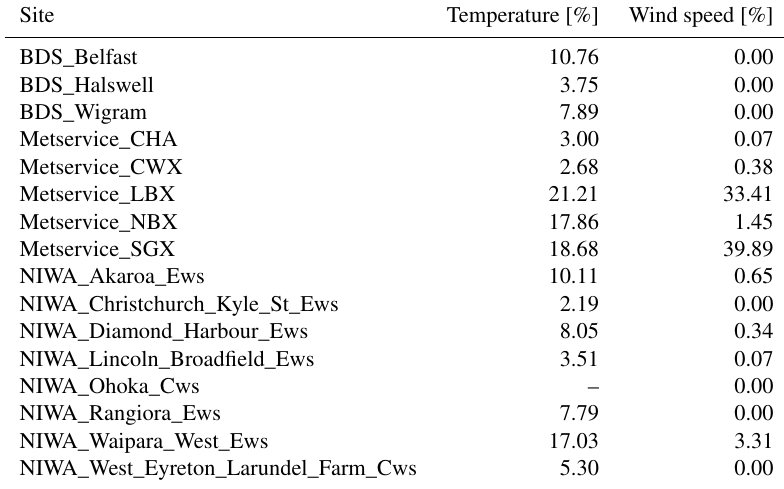
Table 1. The number of temperature and wind speed data points that received a “D” grade on the internal consistency check at each AWS site as a percentage of data points recorded at that